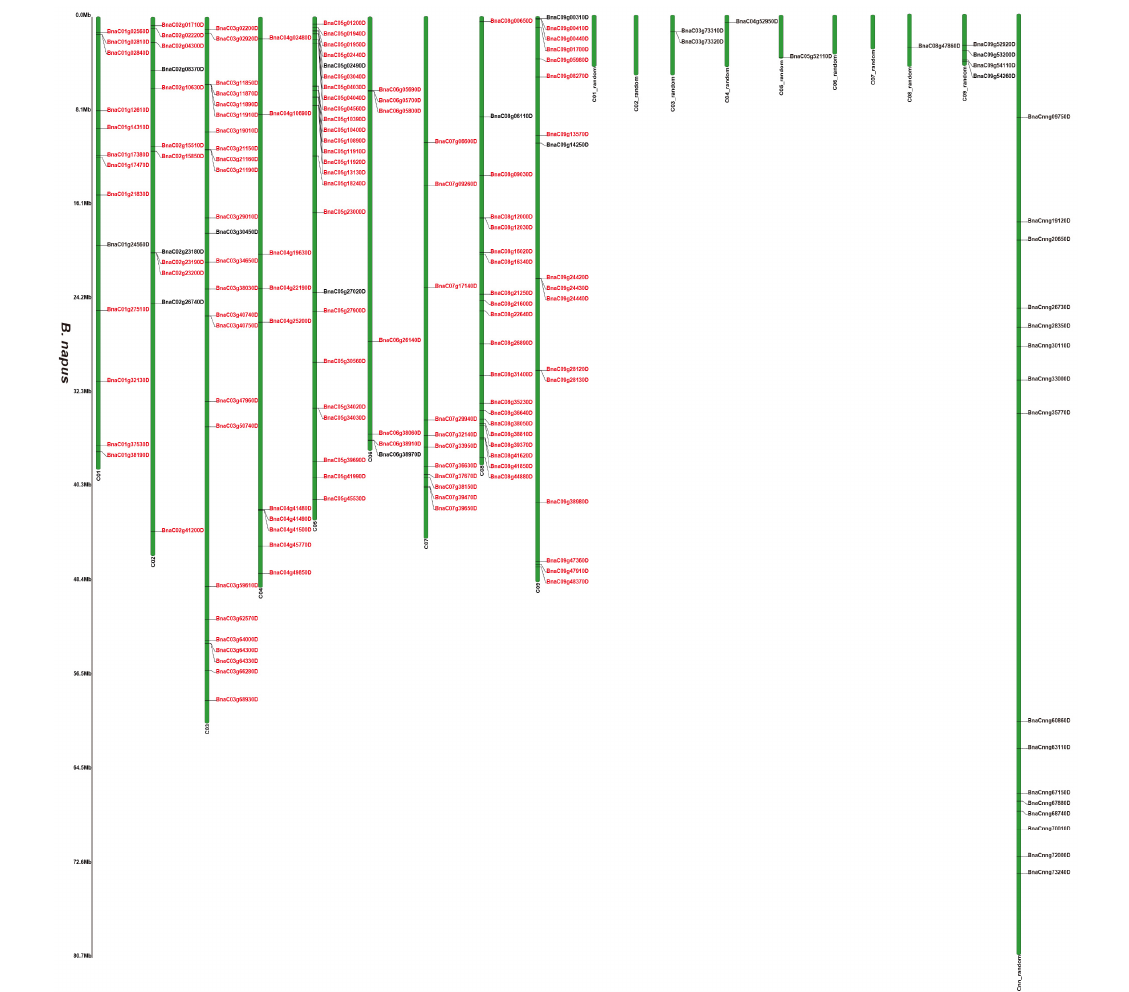
Figure 1. Chromosomal distribution of putative 2OGDs in B. napus . Individual 2OGD positions are shown in Mbs along the chromosome scale. The red label represents the homologous gene.